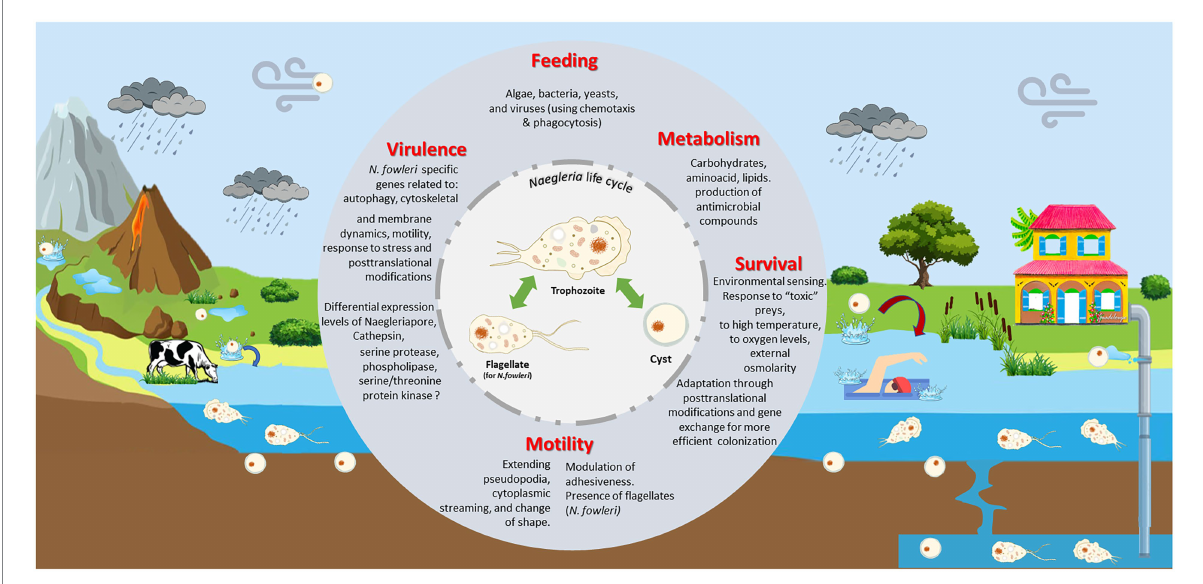
FIGURE 8 Naegleria biology and ecology. Naegleria is found worldwide in natural (such as rivers, lakes, hot springs, underground waters) and man-made (including pipes, swimming pools) aquatic environments and soil habitats. As a free-living genus, they live primarily as an amoeboid trophozoites, moving around using pseudopodia and by changing their shape. They replicate by mitosis and feed mainly on bacteria via phagocytosis, using chemotaxis as a possible hunting mechanism. Though they can obtain nutrients from the environments, they need to adapt their metabolism between feast and starvation conditions. Under nutrient deprivation, trophozoites can transform to resistant and dormant cysts; these can be transported by dust during dust storms. Several Naegleria species (namely N. fowleri ) can exhibit a flagellate state, allowing to move around more rapidly searching for food or stressless situations. This incredible ability to swap between different forms must requires significant biochemical and genetic modifications. Naegleria can use other strategies to survive to stress (oxidative and osmotic stress, high temperatures, toxic preys, and predators) namely through macromolecule modification and post-translation modifications (PTMs). Genes acquired by lateral gene transfer can also provide additional help to survive in harsh situation. Few species are pathogenic but Naegleria fowleri trophozoites can opportunistically infect animals and humans. If water containing N. fowleri enters the nose, the trophozoite can enter the nasal cavity, travel to the brain and feed on the brain, beginning with the meninges. As several virulent-associated genes (such as Cathepsin and Naegleriapore pore) were found in non-pathogenic N. gruberi and N. lovaniensis and pathogenic N. fowleri , this suggests that high-pathogenicity of N. fowleri might be linked to differential expression of these genes and/or related to N. fowleri specific genes involved in autophagy, motility, membrane and cytoskeleton dynamics, and even